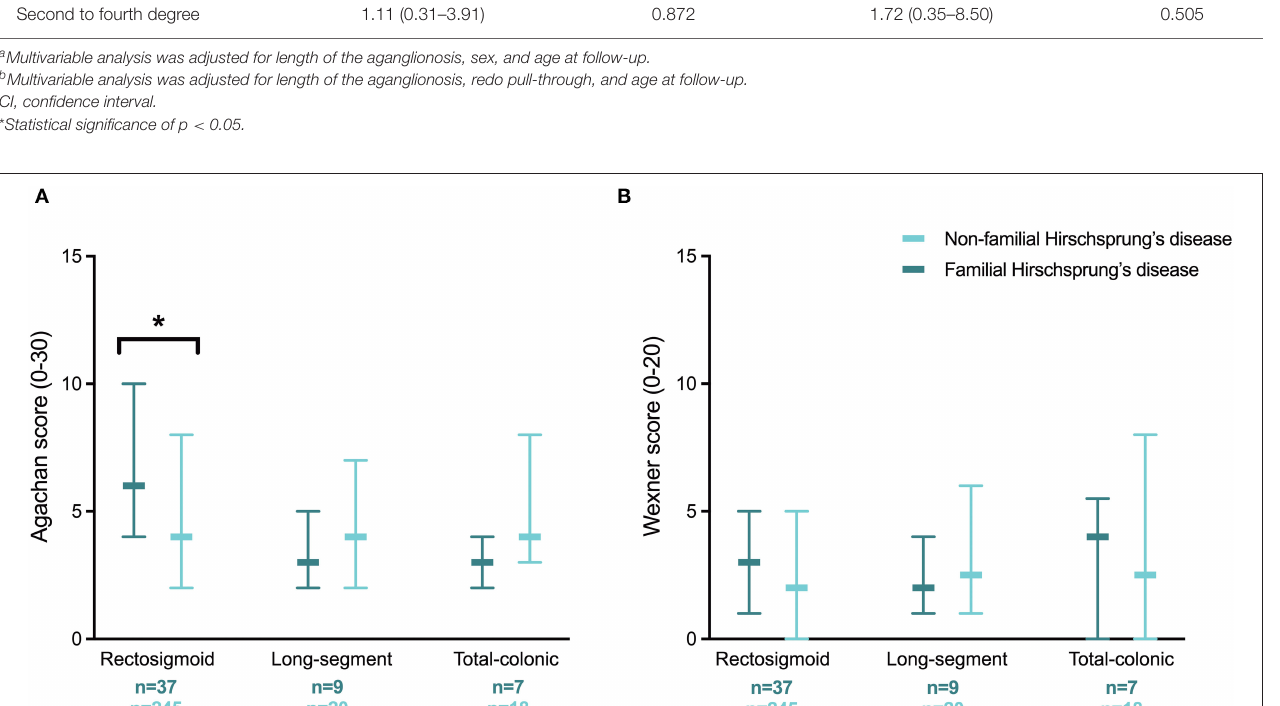
of aganglionic length ( Figure 3B ). The Wexner score was also not significantly different between patients with a first- degree relative with Hirschsprung’s disease vs. a second- to fourth-degree relative (median 3.0 vs. 2.0, respectively, p = 0.787). total colon ( Figure 4B